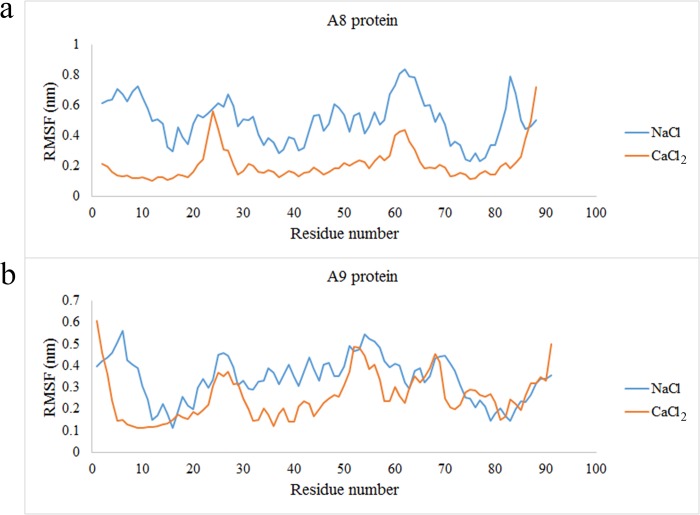
(a,b)The RMSF of A8/A9 complex in presence of Na+ and Ca2+.